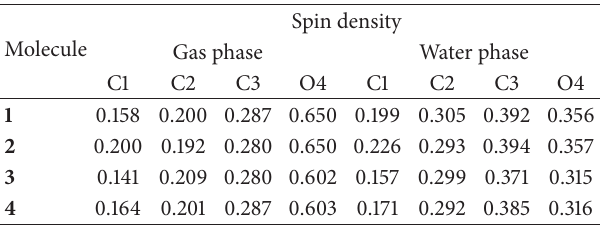
Table 2: Spin densities on carbons 1, 2, 3, and 4 both in gas phase and water (PCM) solvated.